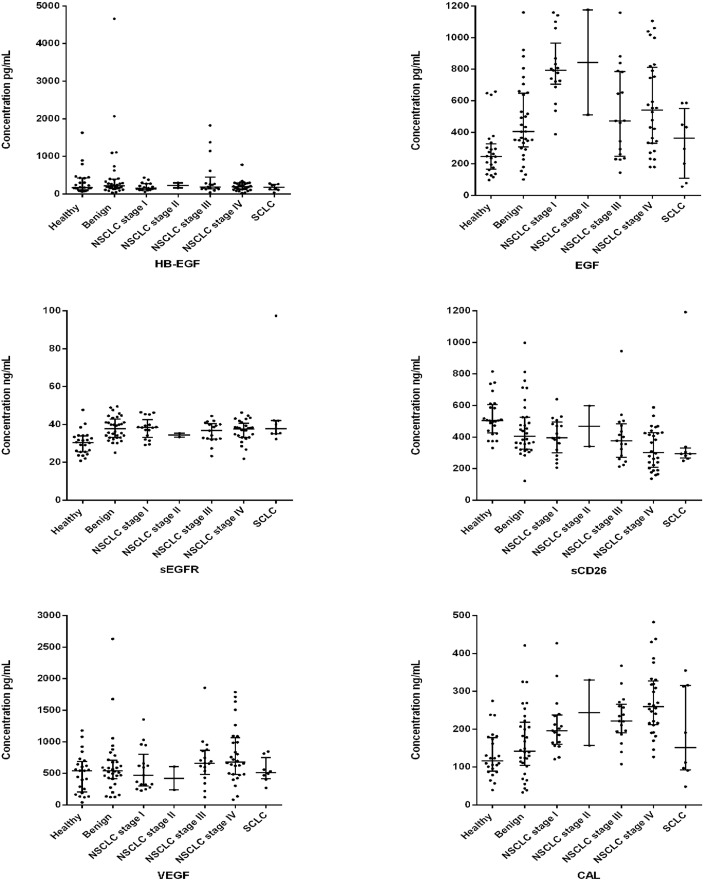
Box-plots of the 6 biomarkers.Box-plots of the levels of the six biomarkers candidates in the sera subgroups of controls and lung cancer patients. Horizontal lines represent median values.